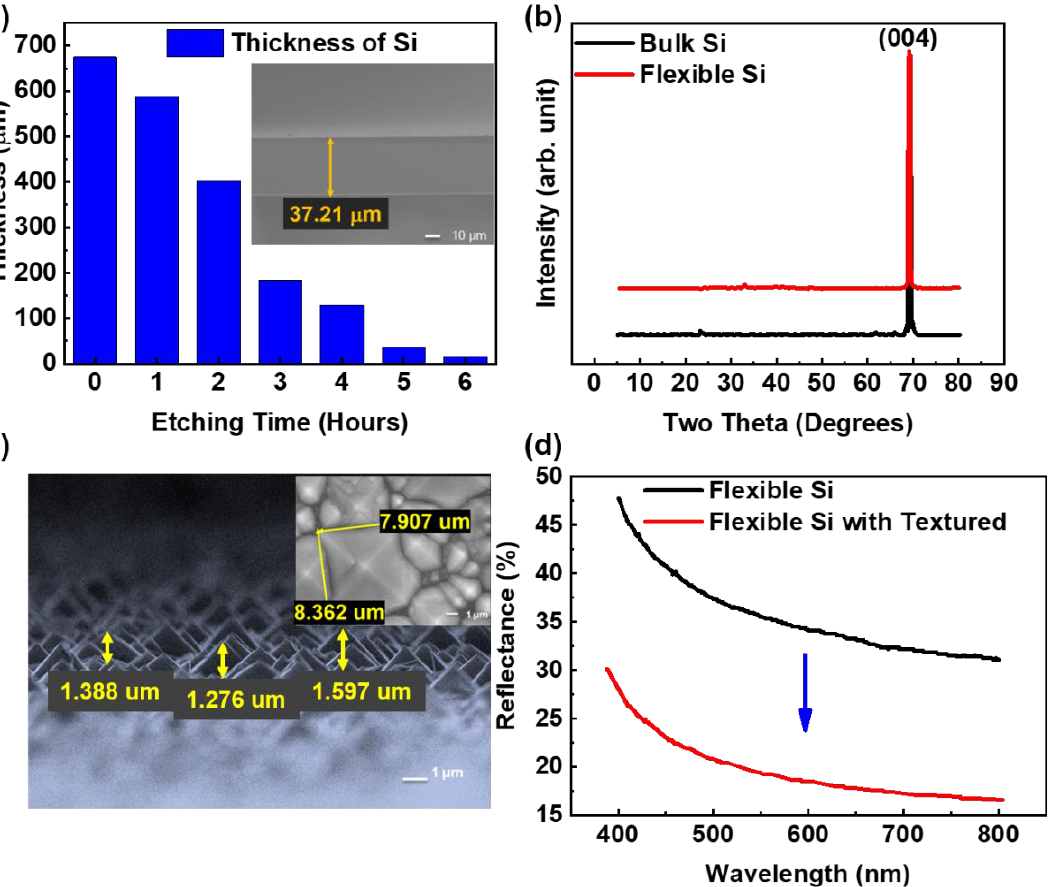
Figure 2. ( a ) The thickness of Si substrates with increasing etching time, ( b ) the XRD results of Si substrates with thicknesses of 675 μm (bulk) and 37.21 μm (flexibility), ( c ) the SEM images of flexible Si substrates with textured structures after NaOH and IPA solution immersion at 70 °C for 30 min, and ( d ) the reflectance of flexible Si with and without surface